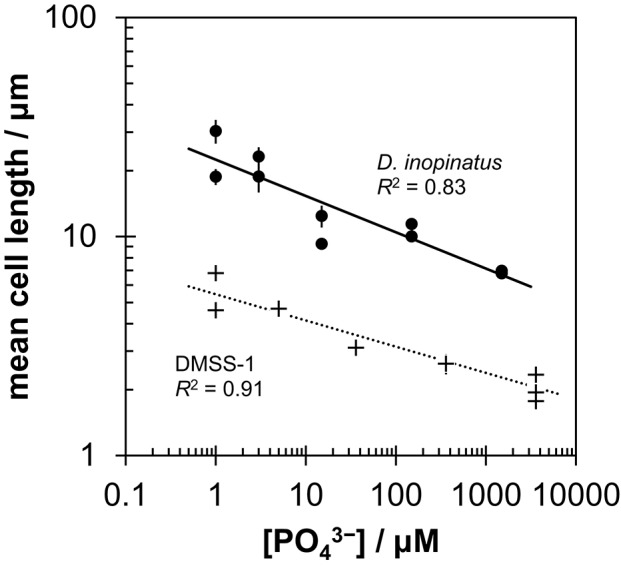
Relationship between mean cell length and initial phosphate concentration in cultures of D. inopinatus (•) and DMSS-1 (+) grown on lactate. Data are from Table 4. Vertical error bars are 1 s.e.m. (standard error of the mean). For DMSS-1, error bars are smaller than the symbols.